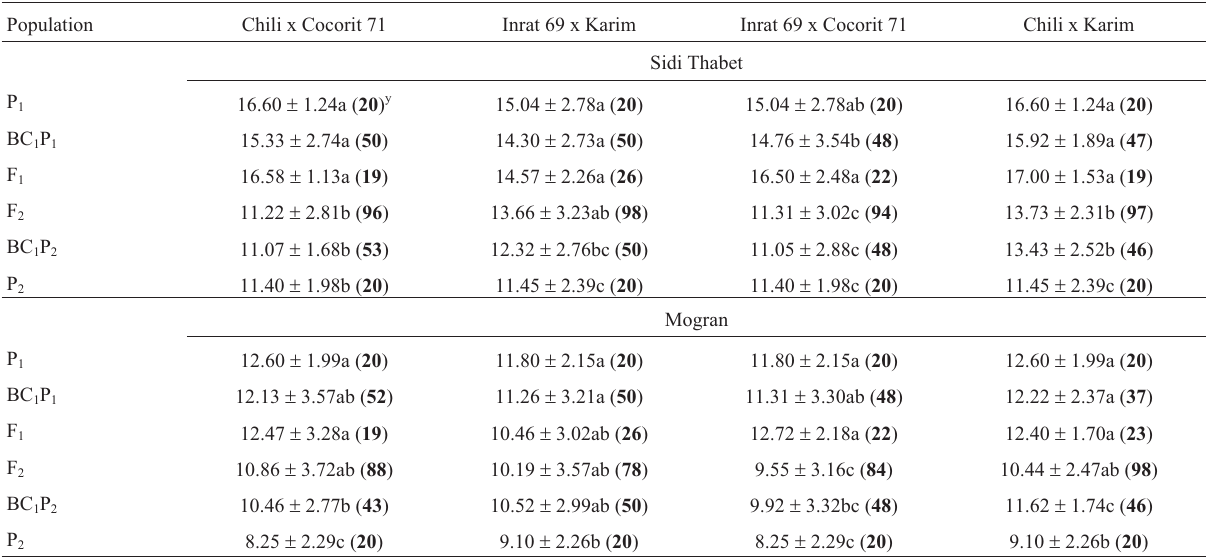
Table 1 - Plant means (cid:2) SE for grain protein (%) in parental and offspring populations from four crosses at two sites (Mogran and Sidi Thabet), with two replications.